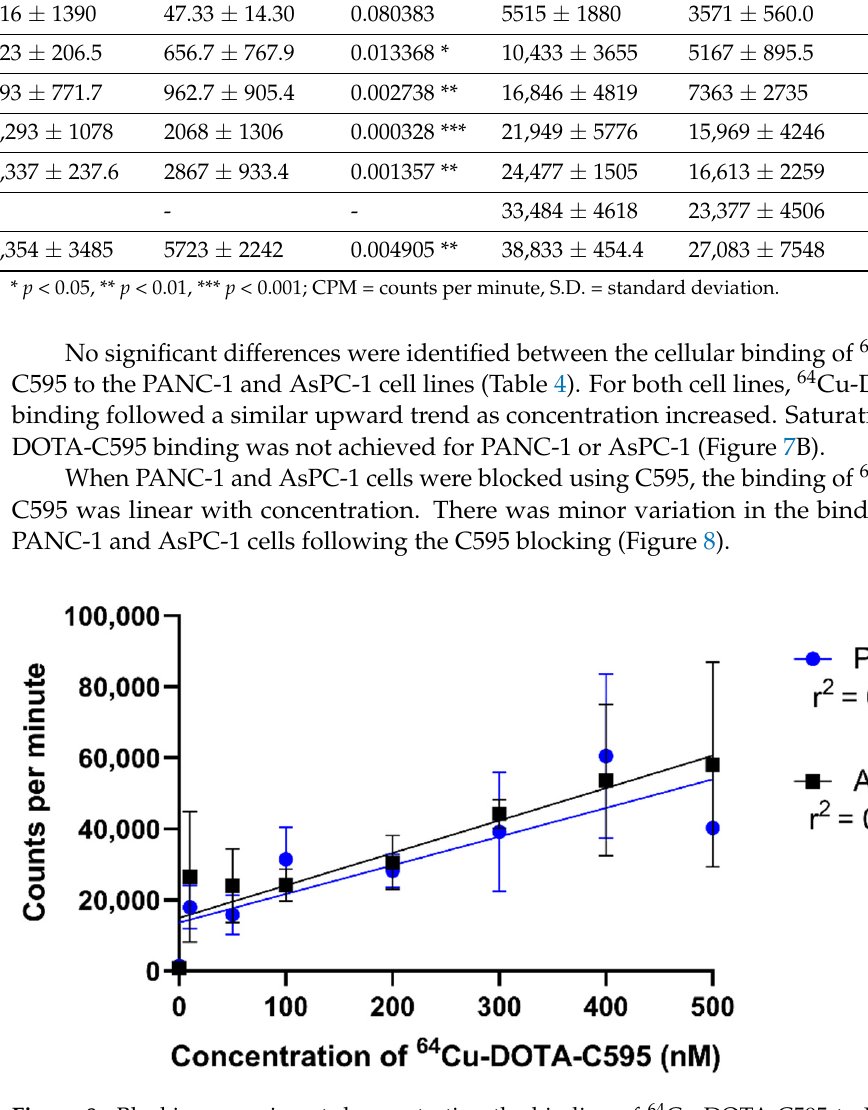
Figure 9. Radiolabelling efficiency using radio-ITLC for radiolabelling of ( A ) 177 Lu and ( B ) 64 Cu to 120-day old DOTA-C595.